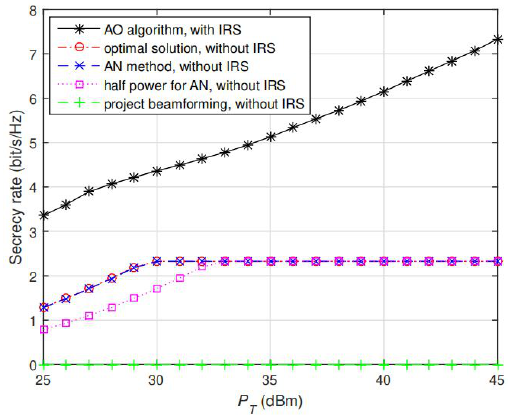
Figure 2. Secrecy rate performance comparison between AO algorithms with IRS and other solutions without IRS. P T is fixed at 30 dBm, the channels are randomly generated. Our proposed algorithm significantly boosts the secrecy rate compared with the existing solutions without IRS.